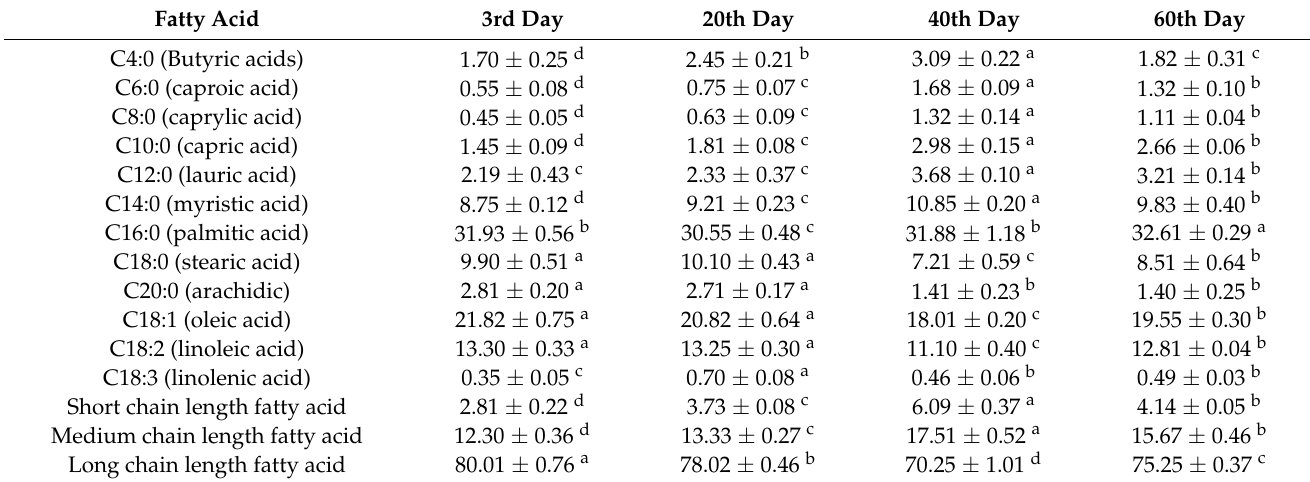
Table 5. Fatty acids composition of SBL-extract-added cheese samples at different storage